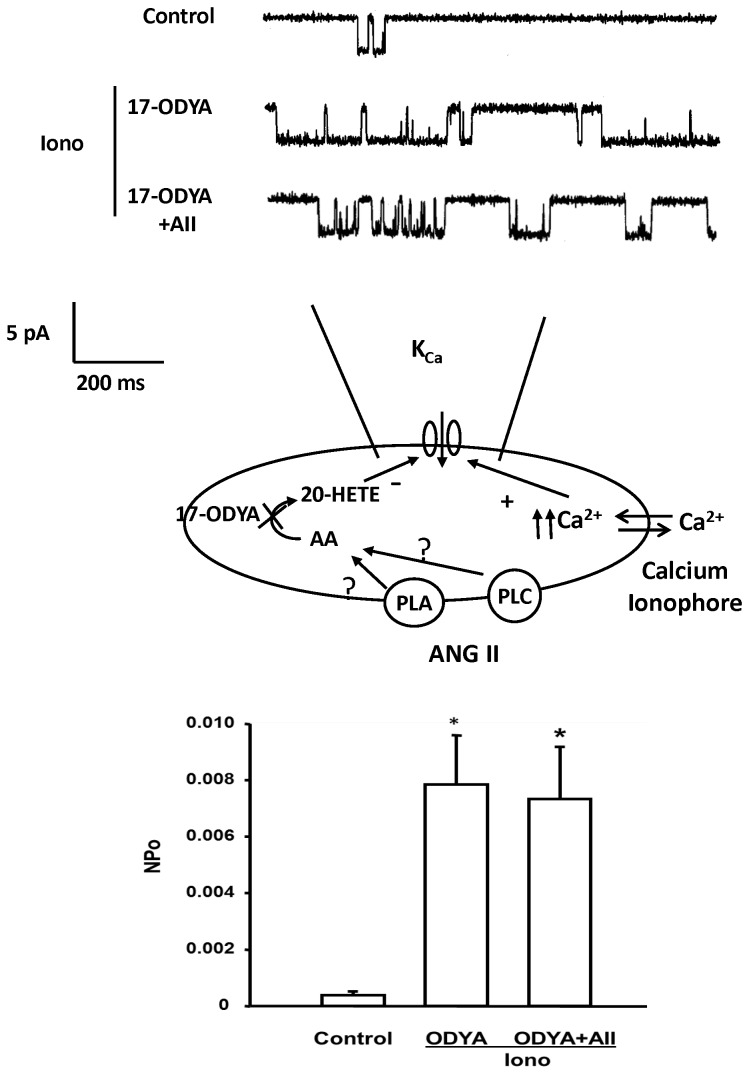
Effect of 17-ODYA on the inhibitory action of ANG II on KCa channel activity in renal VSM cells.Upper panel presents a representative tracing KCa channel activity in the cell-attached mode before and after addition of 17-ODYA (10-7 M) and 17-ODYA plus ANG II to the bath. KCa channel currents were recorded with 140 mM KCl in the pipette at the resting membrane potential (pipette potential = 0 mV) and the cells were bathed in normal physiological salt solution in the presence of ionomycin. The middle panel summarizes the patch clamp recording mode. Lower panel summarizes the effects of 17-ODYA and 17-ODYA and ANG II on the open probability of the KCa channel in renal VSM cells (n = 4 cells from 4 rats). * indicates a significant difference versus the corresponding control value.